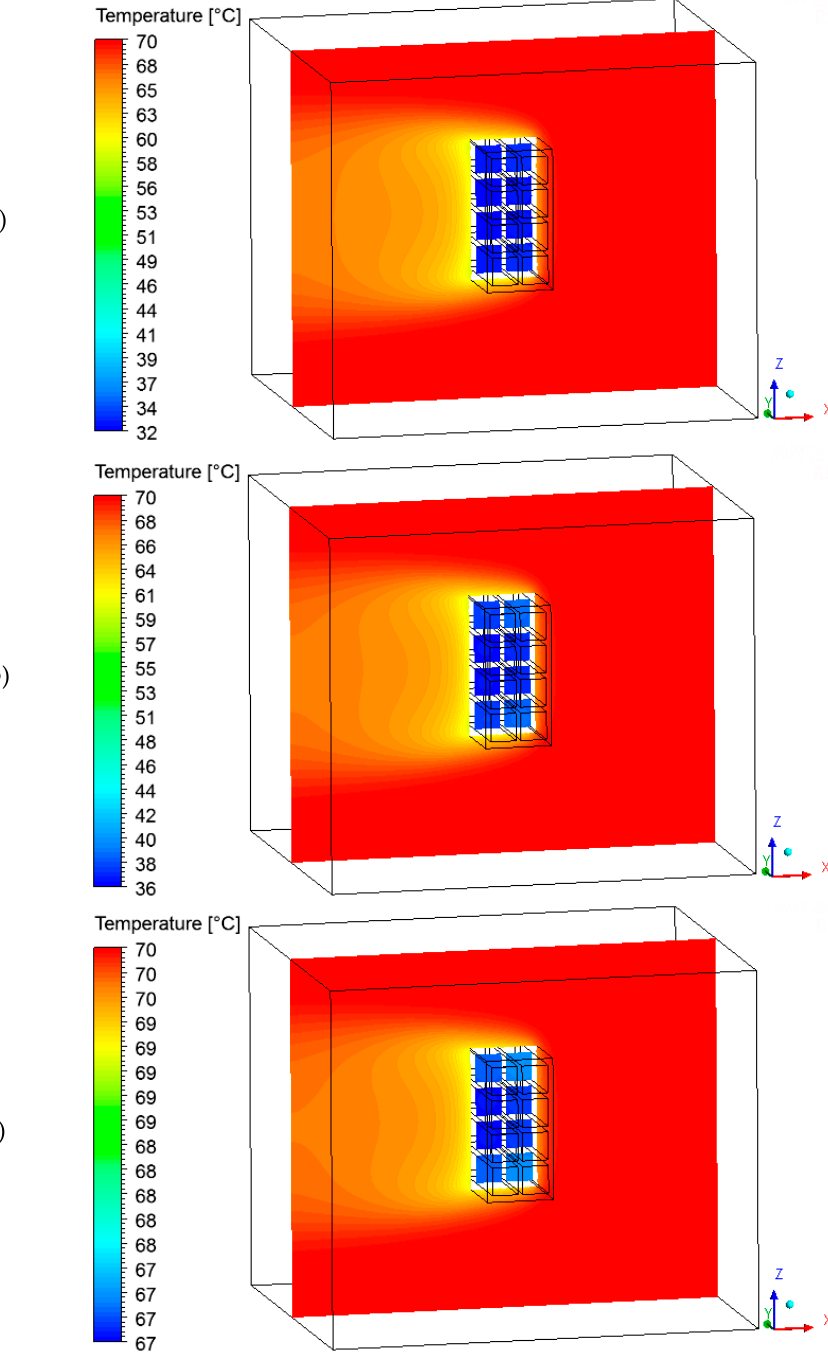
Figure 11. Temperature fields of the air in a plane XZ (Y = 0.2 m) at different moments of drying: ( a ) 10 min, ( b ) 60 min, and ( c ) 950 min.